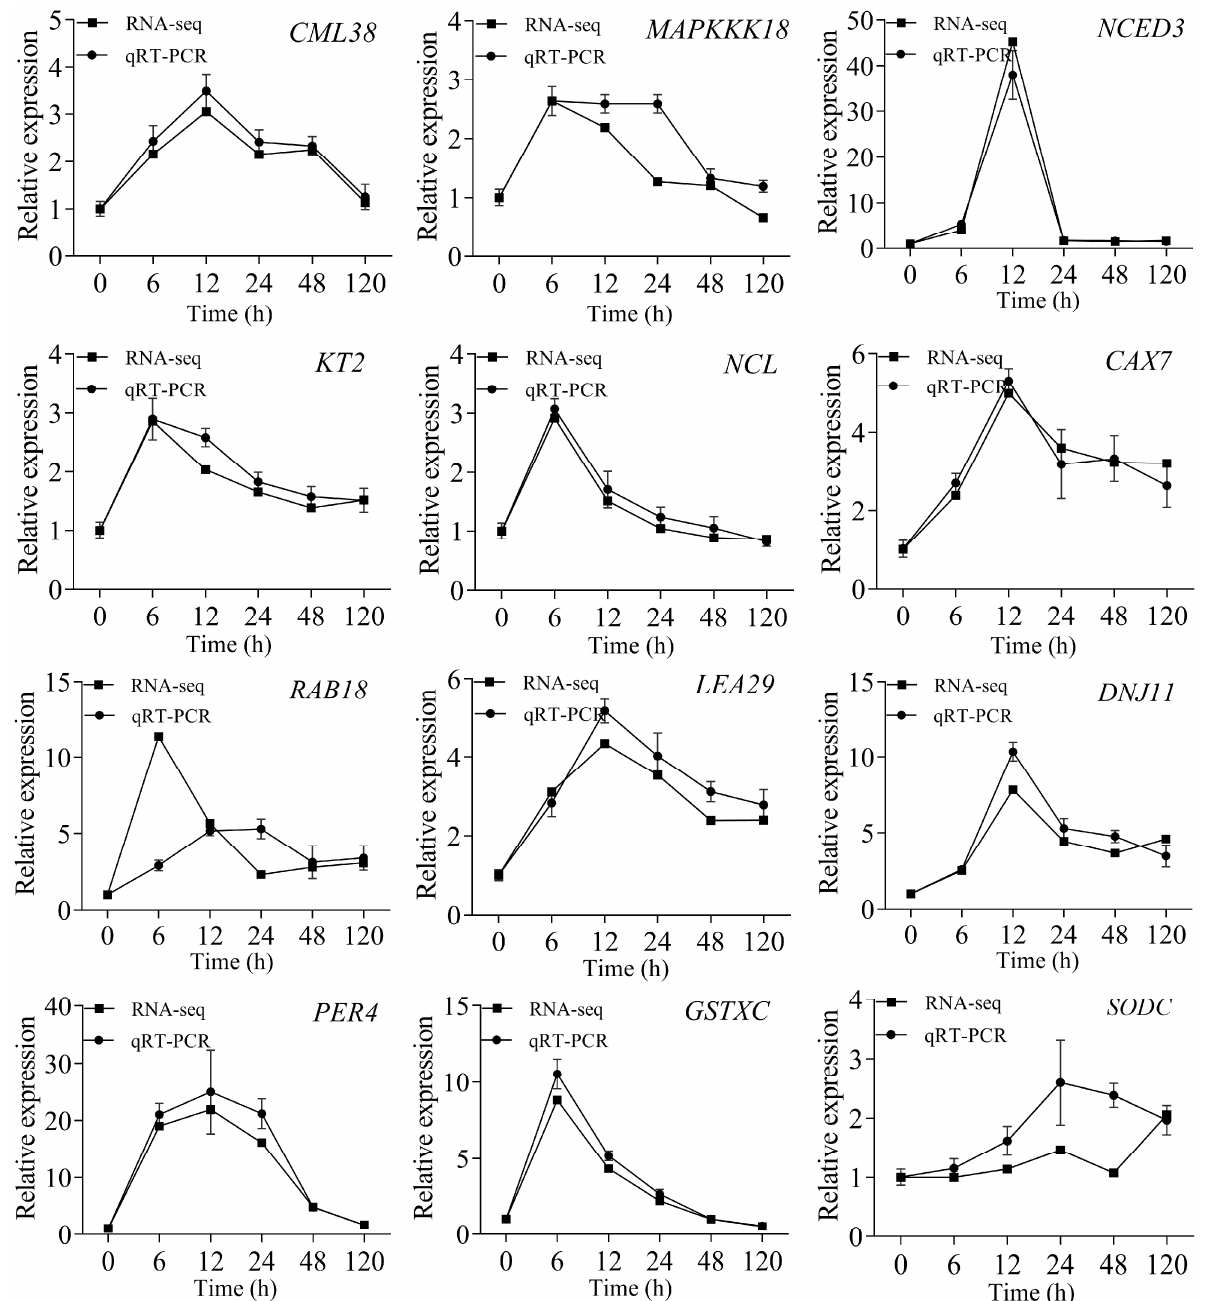
Figure 6. Validation of gene expression levels. The values are shown as the mean of three repli- cates ± SE ( n = 3). replicates ± SE ( n =